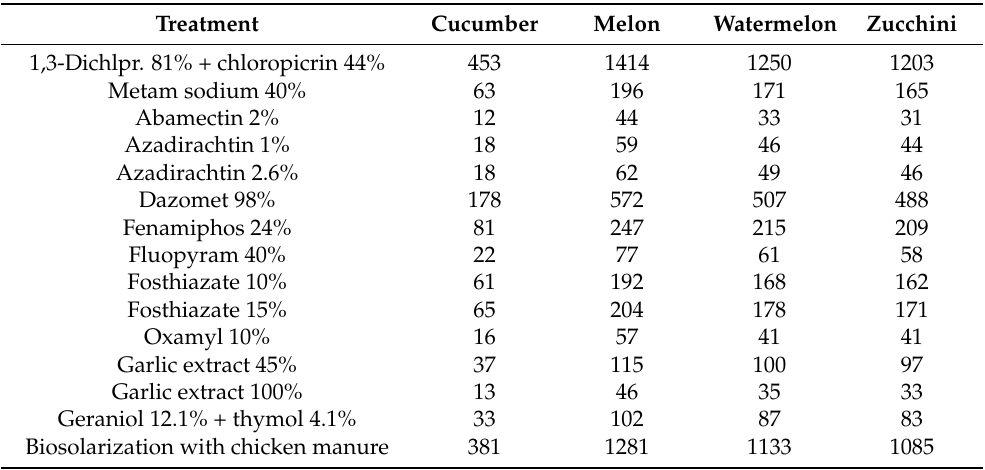
Table 7. Maximum pre-treatment RKN ( M . incognita ) densities (P0) that each nematicidal treatment could manage to get RKN densities at planting (Pi) equal to the economic threshold level in intensive cucurbitaceous crops in southern Spain. Treatment Cucumber Melon